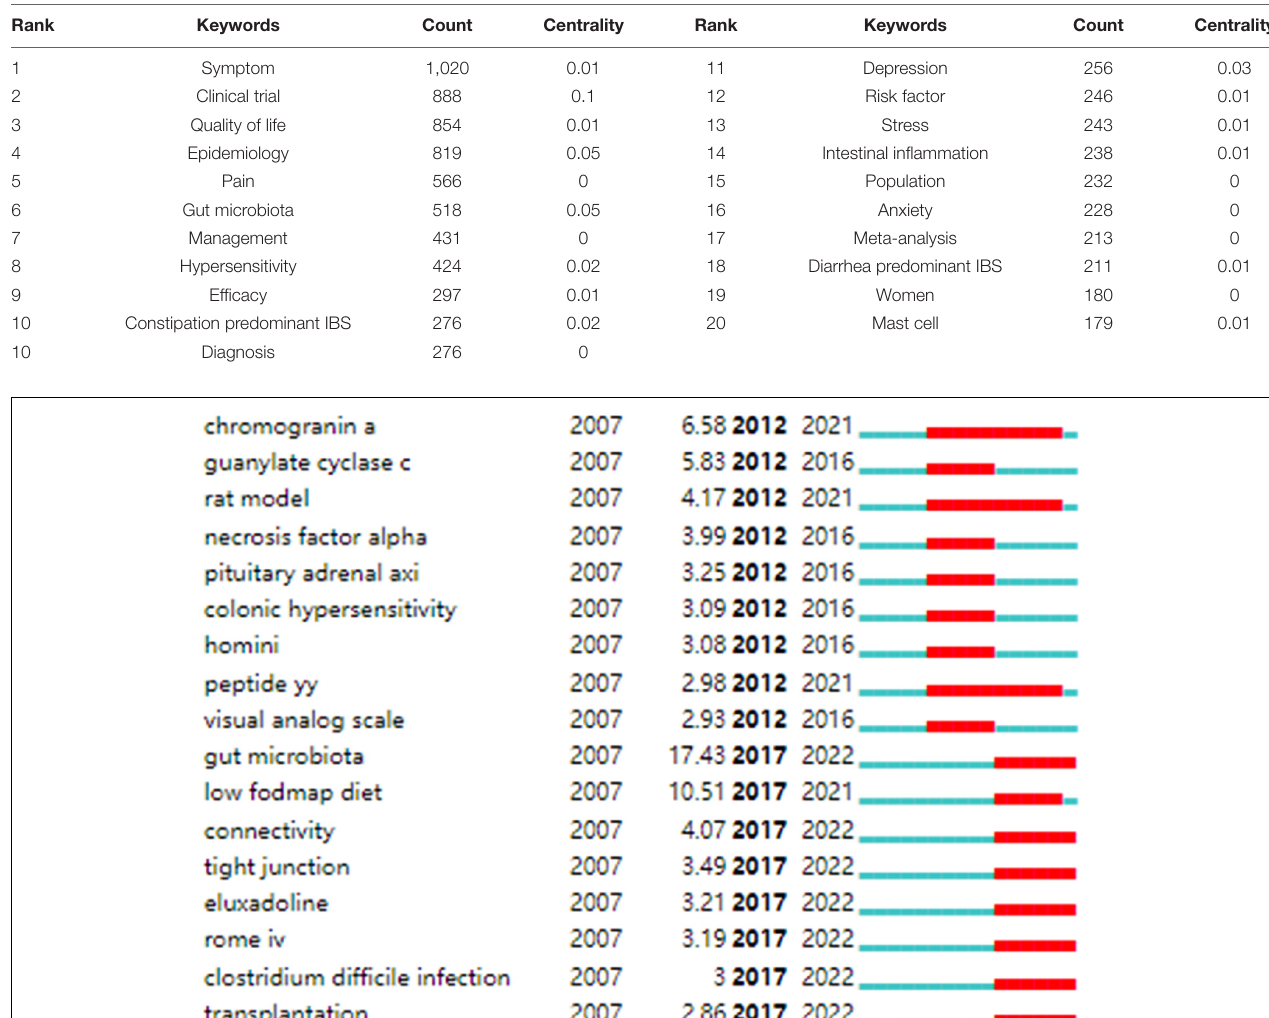
TABLE 6 | Top 20 keywords with the highest count in IBS research.